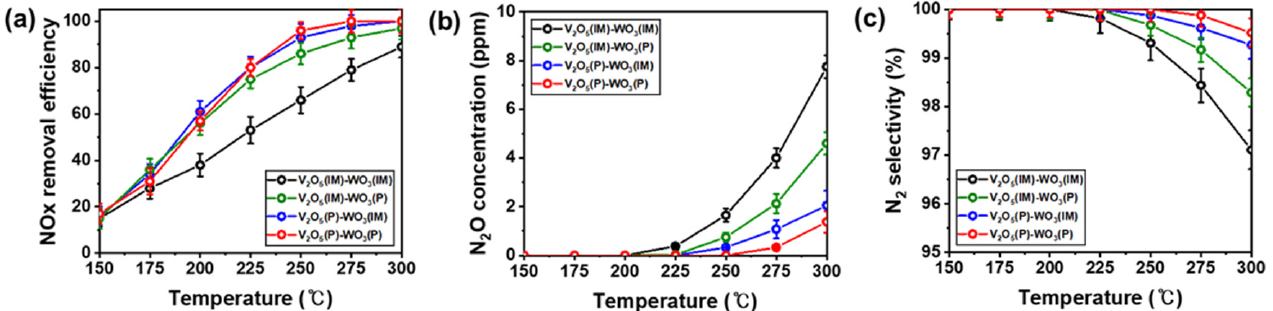
Figure 3. ( a ) Nitrogen oxide (NO X ) removal efficiency. ( b ) N 2 O concentration and ( c ) N 2 selectivity of V 2 O 5 (IM)–WO 3 (IM), V 2 O 5 (IM)–WO 3 (P), V 2 O 5 (P)–WO 3 (IM), and V 2 O 5 (P)–WO 3 (P). Reaction condi- tions: [NO] = [NH 3 ] = [SO 2 ] = 300 ppm, [O 2 ] = 5 vol.%, N 2 as a balance, and [GHSV] = 60,000 h − 1